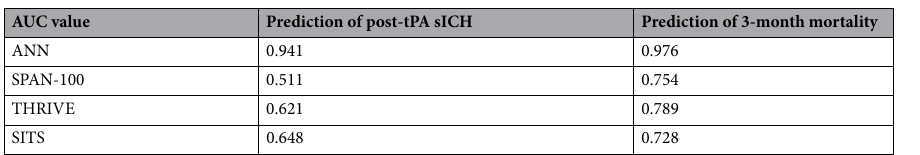
Table 4. Comparison of the predictive performance of different models. The AUC value of ANN models showed the mean AUC of the five validation sets. The AUC value of SPAN-100 index was calculated using a univariable regression model with SPAN-100 score (age plus NIHSS). Compared to the SPAN, THRIVE, and SITS scores, the predictive performance was remarkably higher in the ANN models. ANN, artifice al neural network. AUC, the area under the receiver operating characteristic curve. NIHSS, National Institutes of Health Stroke Scale. sICH, symptomatic intracerebral hemorrhage. SITS, Safe Implementation of Treatments in Stroke score. SPAN-100, Stroke Prognostication using Age and NIH Stroke Scale index. THRIVE, Totaled Health Risks in Vascular Events score. tPA, tissue plasminogen activator.